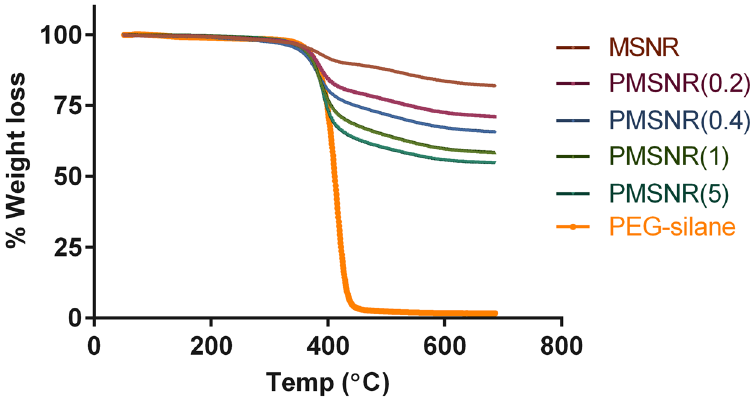
Figure 2. Thermogravimetric analysis (TGA) of MSNR and PMSNR. TGA was performed in air with the temperature ramped from 50–700 °C at a rate of 1 °C/min.